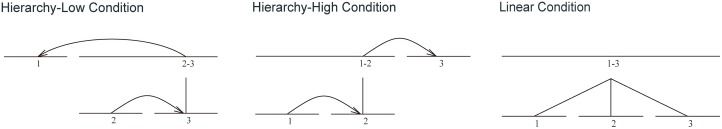
Hierarchical structures for example discourses.